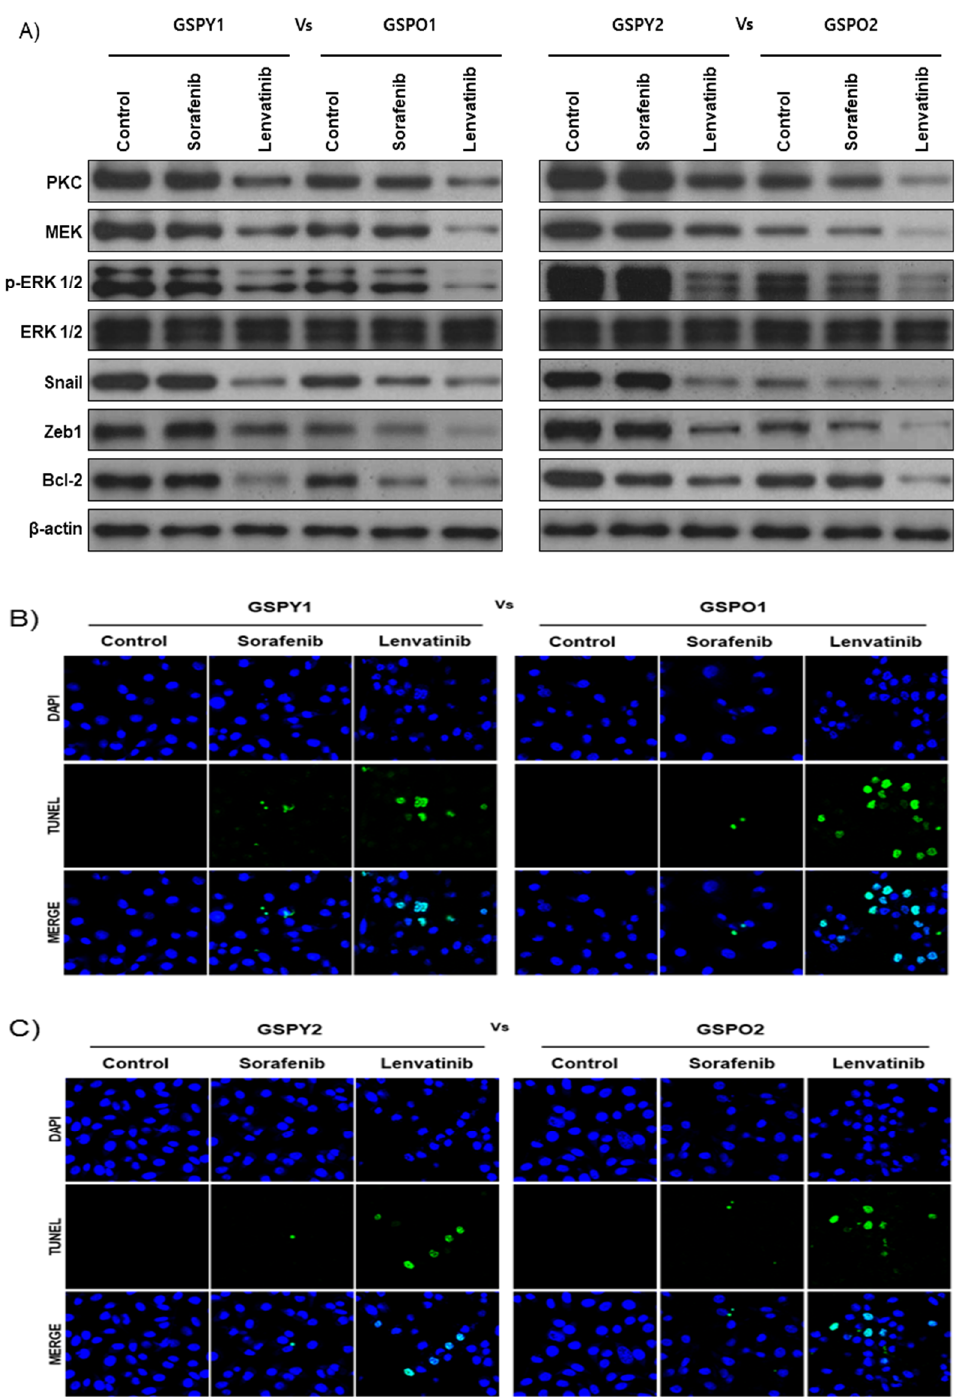
Figure 3. The expression of markers associated with the FGFR signaling pathway, EMT, and anti-apoptosis were significantly suppressed by lenvatinib compared with that by sorafenib. ( A ) Immunoblot analysis for markers of FGFR signaling pathway (PKC, MEK and p-ERK1/2), EMT (Snail and Zeb1), and anti-apoptotic factor (Bcl-2) in young (GSPY) and older (GSPO) patient-derived papillary thyroid cancer cells. ( B , C ) TUNEL assay of GSPY and GSPO; TUNEL-positive (apoptotic) cells are indicated (×400): ( B ) GSPY1 vs. GSPO1; ( C ) GSPY2 vs. GSPO2.